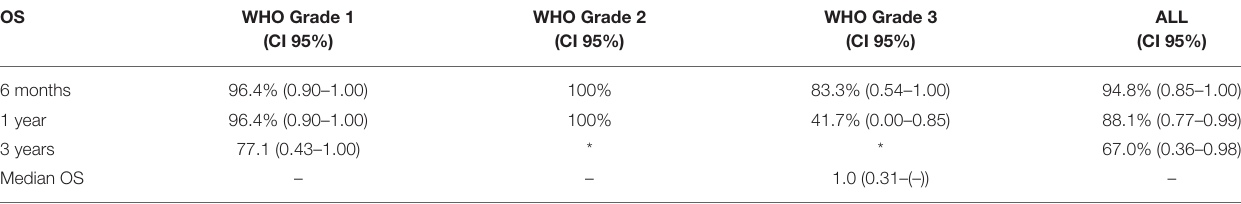
TABLE 4.1 | Median overall survival and overall survival at 6 months, 1, and 3 years ( n =